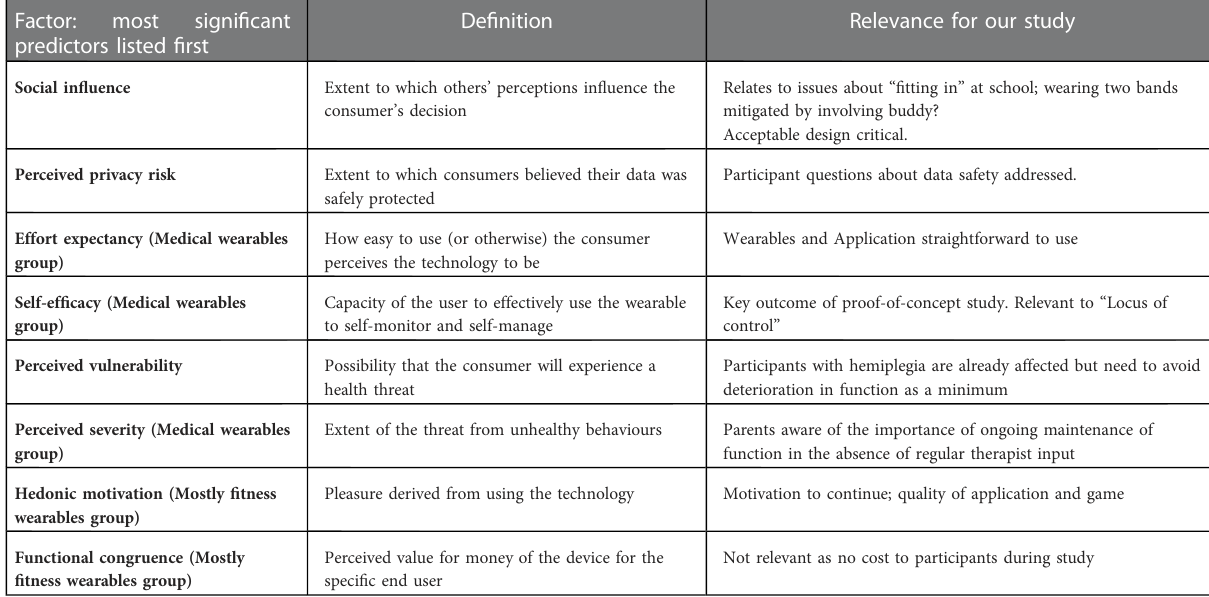
TABLE 3 Predictors of use of wearables (adapted from Gao et al. 2015).